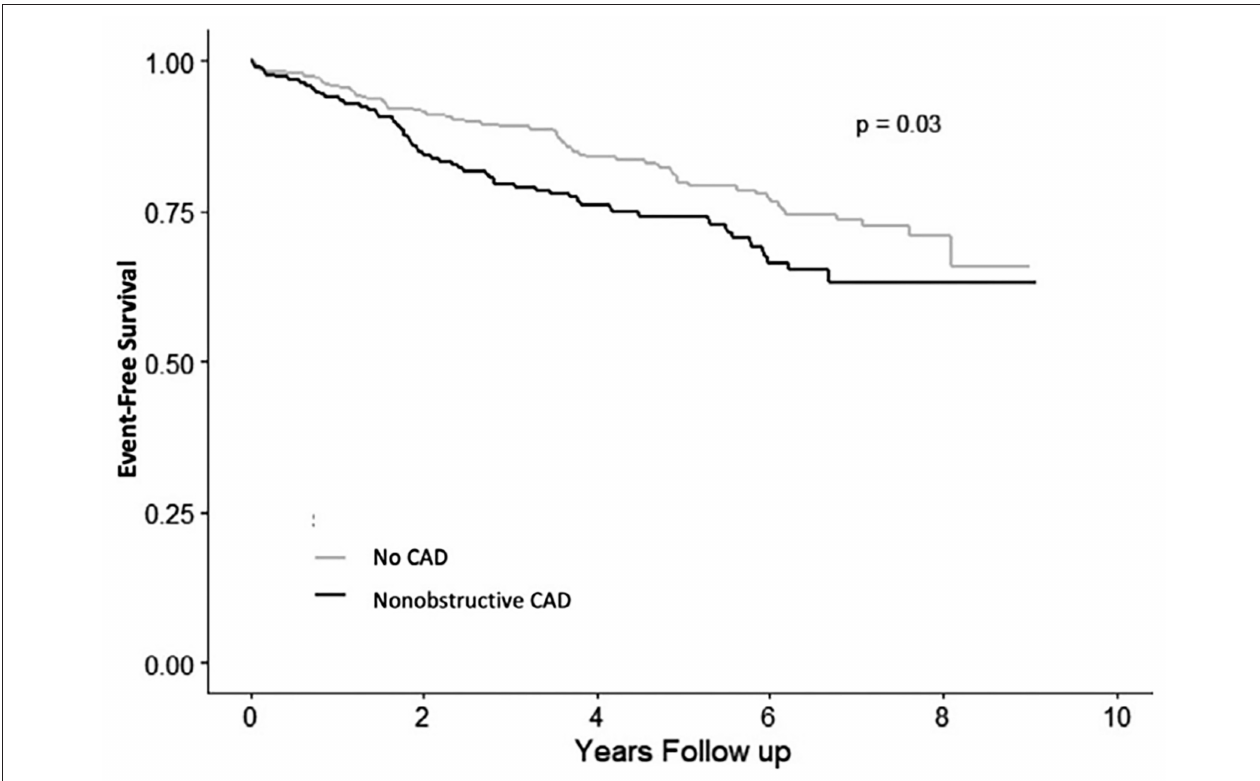
FIGURE 7 | Angina hospitalization rates in women with signs and symptoms of ischemia but no obstructive CAD. Angina hospitalization event-free survival in women with no CAD ( < 20% stenosis) and non-obstructive CAD ( ≥ 20 to < 50% stenosis). Reprinted with permission (104).